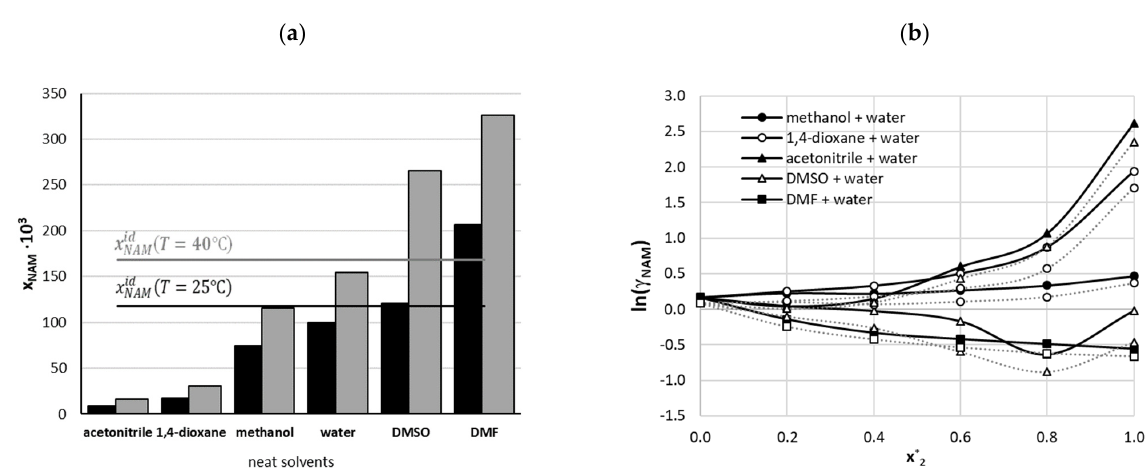
Figure 4. Characteristics of non-ideality of nicotinamide solubility in neat and binary solvents. ( a ) Comparison of ideal solubility measured at temperatures 25 ◦ C and 40 ◦ C; ( b ) solvent ratio dependent trends of activity coefficients of nicotinamide in studied binary solvents mixtures at 25 ◦ C (solid black symbols) and 40 ◦ C (grey open symbols).